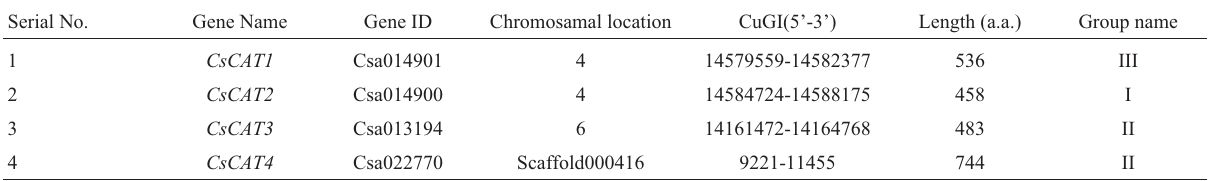
Table 1 - The CsCAT genes identified in this study. The number designations are based on the order of the multiple sequence alignments. Serial